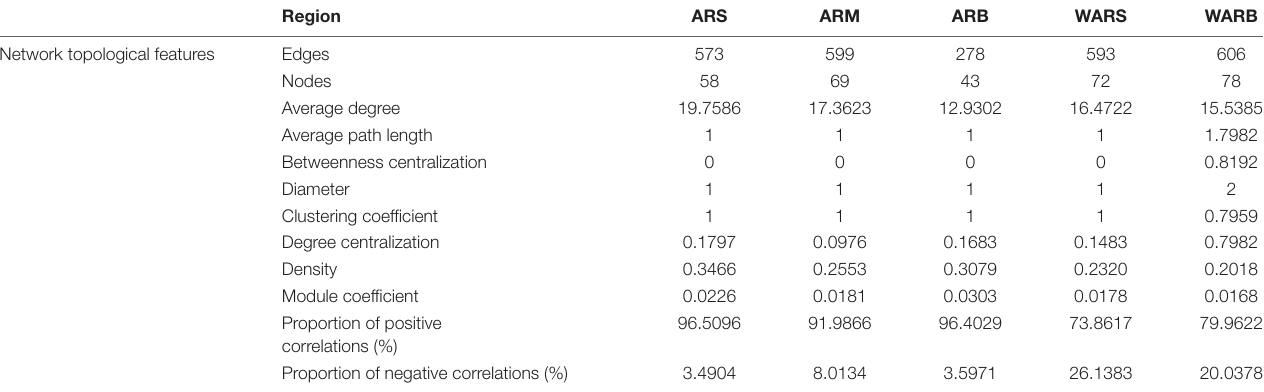
TABLE 3 | Key topological features of protist networks in different sampling areas.